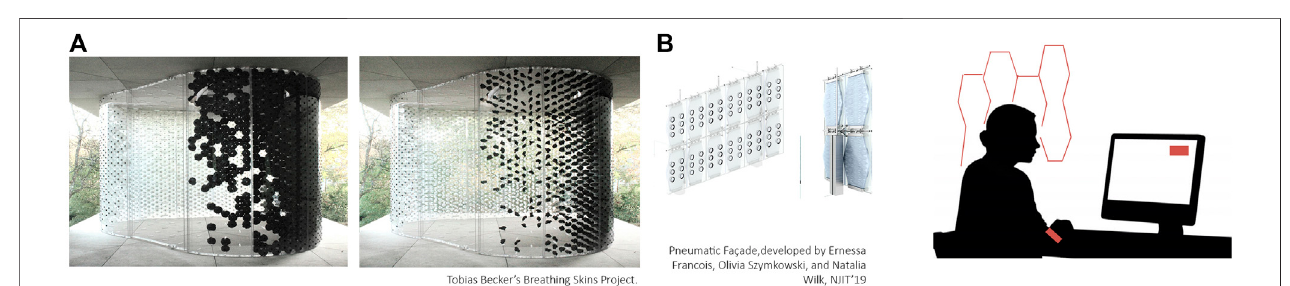
Frontiers in Computer Science |